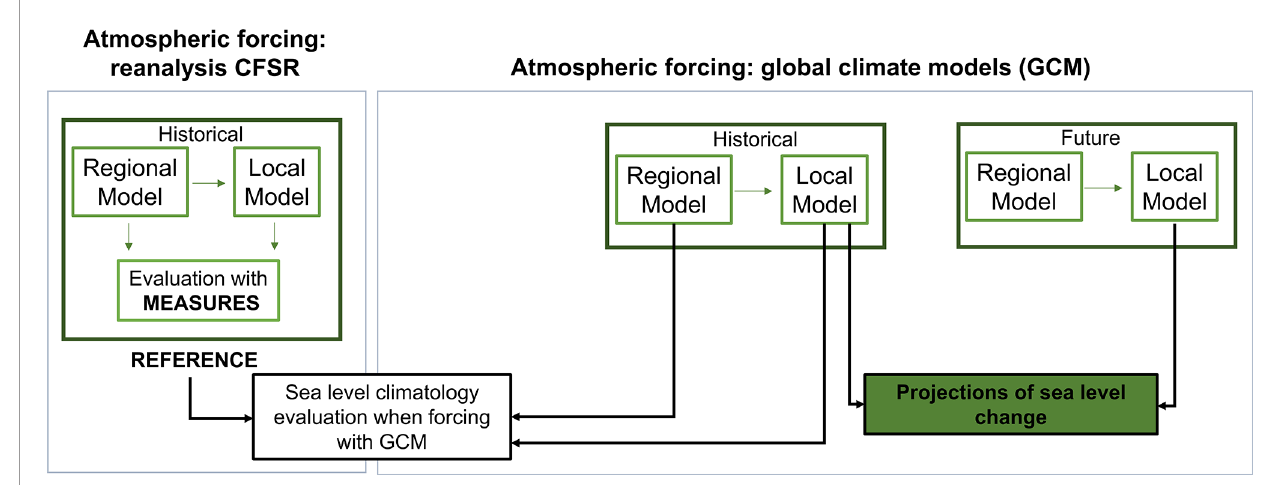
FIGURE 2 | Flowchart representing general